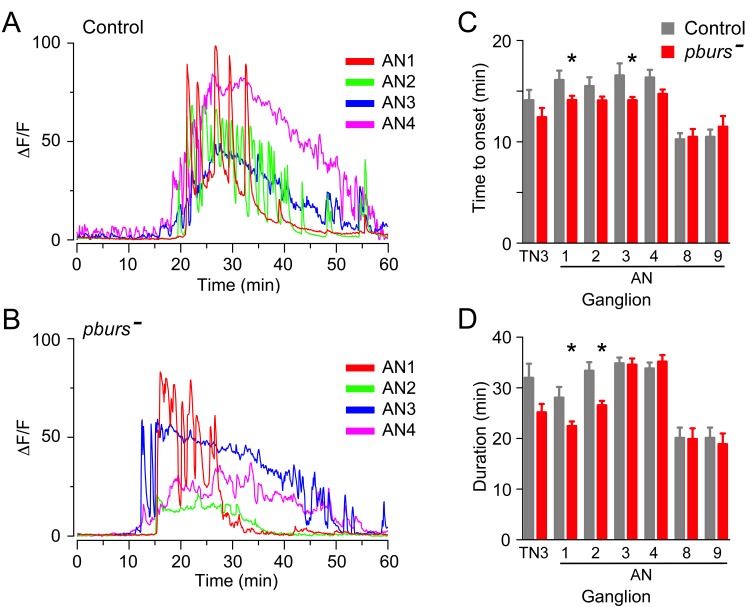
Absence of PBURS affects response of CCAP neurons to ETH.(A,B) Pattern of GCaMP activity in CCAP neurons AN1-4 induced by ETH in CNS from control animals (A) and in CNS of animals hemizygous mutant for pburs (B). Zero min indicates time of ETH challenge. (C,D) Summary of results obtained for latency (C) and duration (D) of response, summarized as described in Figure 5. N = 7–10 for all genotypes and preparations. Data in (C,D) are mean ± SEM. Significant differences (p<0.05) compared to control are indicated by '*'; t test (unpaired, two-tailed). Actual p values can be found in Supplementary file 1. The amplitude of the responses was also affected; see text and Figure 3—figure supplement 1. Genotypes: Control: CCAP-LexA+LexAop-GCaMP. pburs[-]: pburs[-]/Df(2)pburs + CCAP-LexA+LexAop-GCaMP; see Materials and methods for exact genotypes.